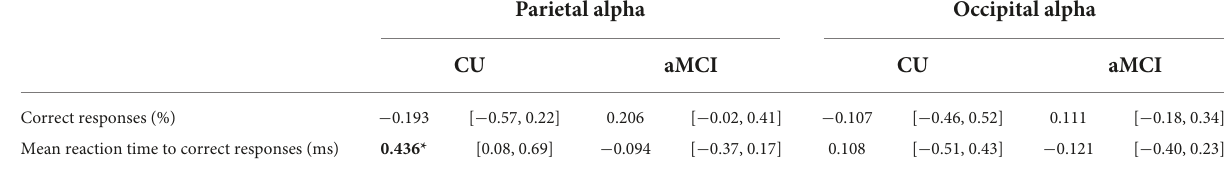
TABLE 5 Correlation coefficients (Pearson’s r ) and correspondent 95% CI between eLORETA source solutions (normalized alpha current source density) of parietal and occipital alpha rsEEG rhythms and episodic memory task performance for CU seniors and patients with aMCI. Parietal alpha Occipital alpha